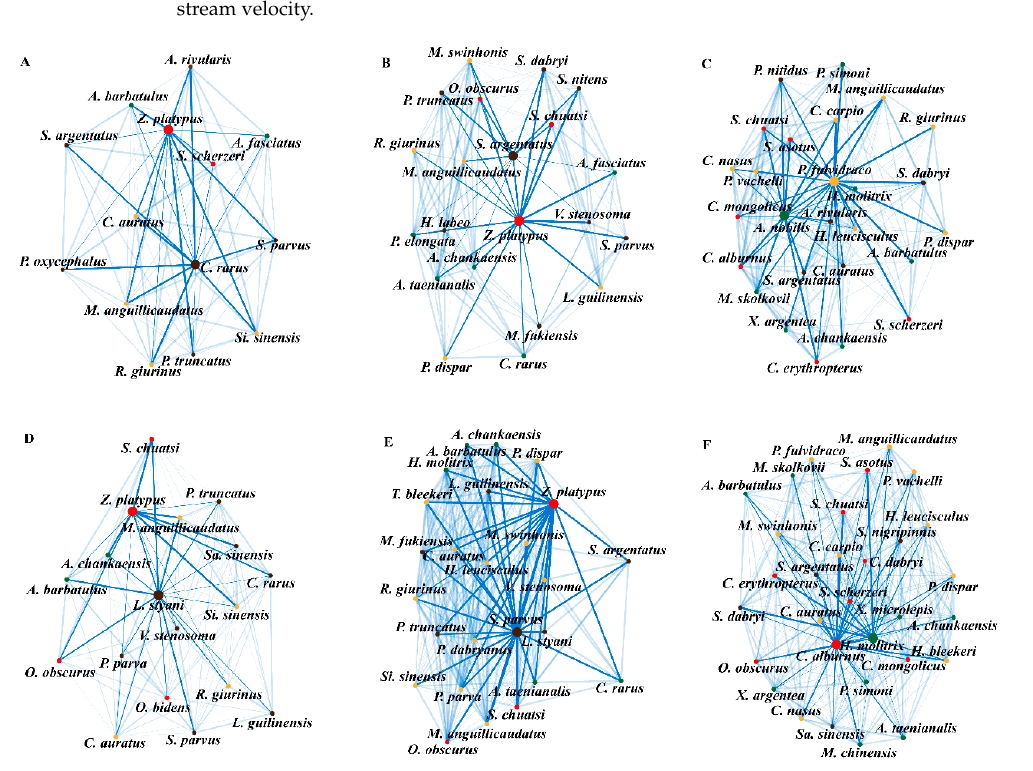
Figure 3. Fish interaction networks of the Qiupu River for second-order to fourth-order stream sites during the dry ( A – C ) and wet ( D – F ) seasons. Each edge has a width proportional to its condi- tional probability. Node colours correspond to species showing different feeding habits: (1) yel- low: omnivore; (2) red: piscivore; (3) brown: invertivore; and (4) dark green: herbivore. Table 1. Model fit diagnostics and prediction errors for each Poisson log-normal (PLN) models.